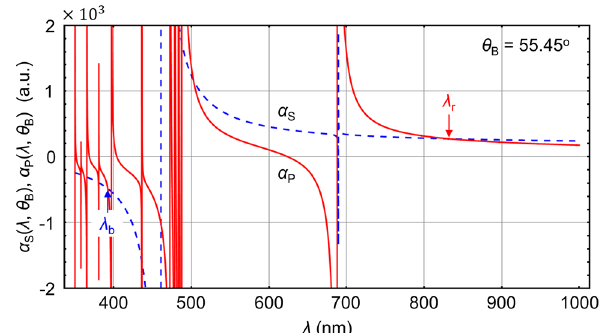
(cid:31) , θ S,P ( B ) of = 392.58 nm, =